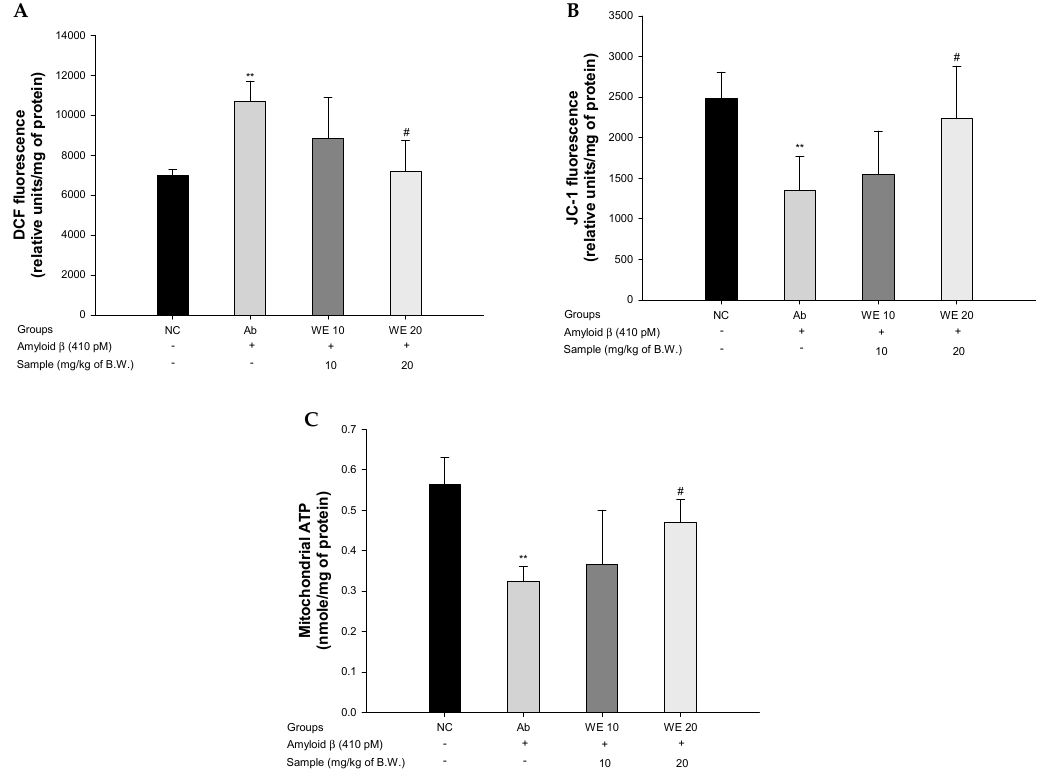
Figure 6. Protective effect of walnut ( Juglans regia L.) extract on A β -induced mitochondrial dysfunction: ( A ) reactive oxygen species (ROS) levels, ( B ) mitochondrial membrane potential (MMP) levels, ( C ) ATP contents of the mitochondria in mice brain tissues. Results shown are means ± SD ( n = 5). Data are statistically represented at * = significantly different from the NC group; # = significantly different from Ab group, respectively; # p < 0.05, ** p < 0.01.